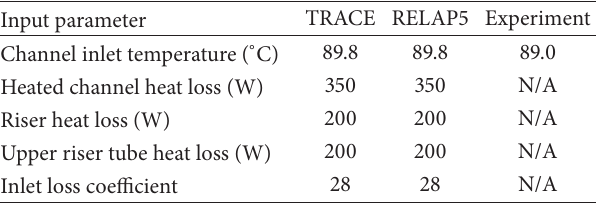
Table 2: Calibrated values of uncertain input parameters, test S-1. Input parameter